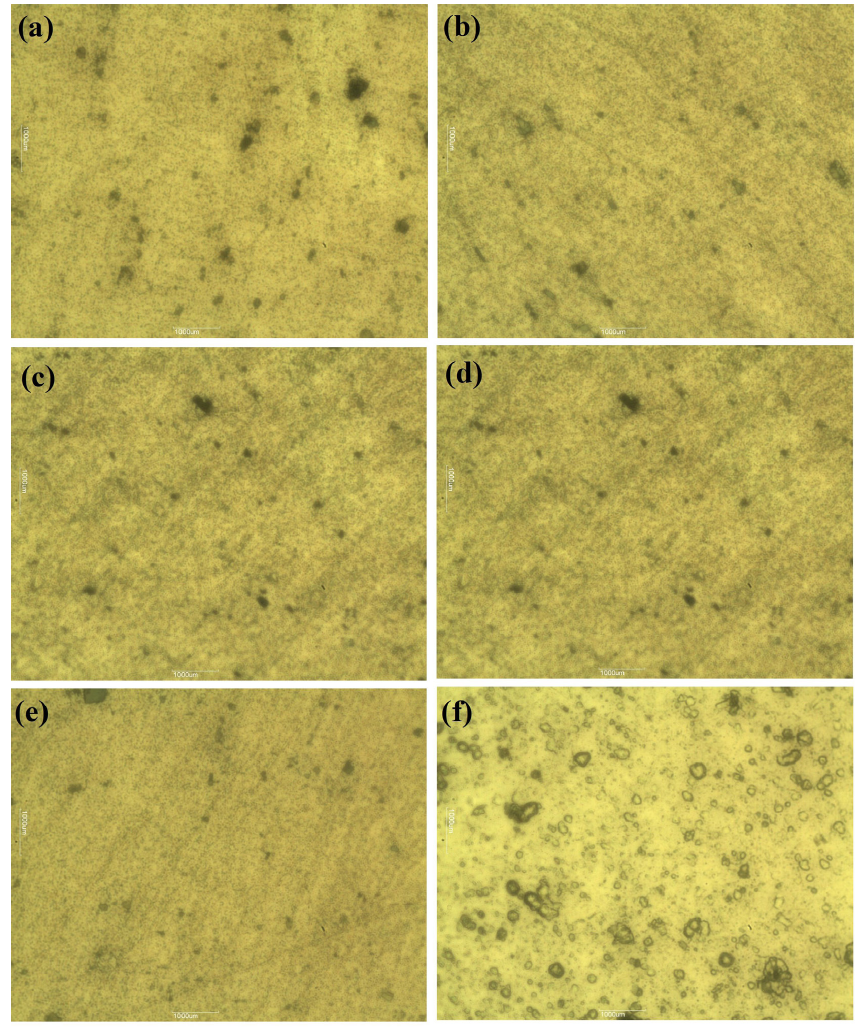
Figure 6. AA 5182 aluminum alloy microstructure heated to (a) 50 °C, (b) 100 °C, (c) 150 °C, (d) 200 °C, (e) 250 °C, (f) 300 °C for a period of 10 min. (polished and magnified to